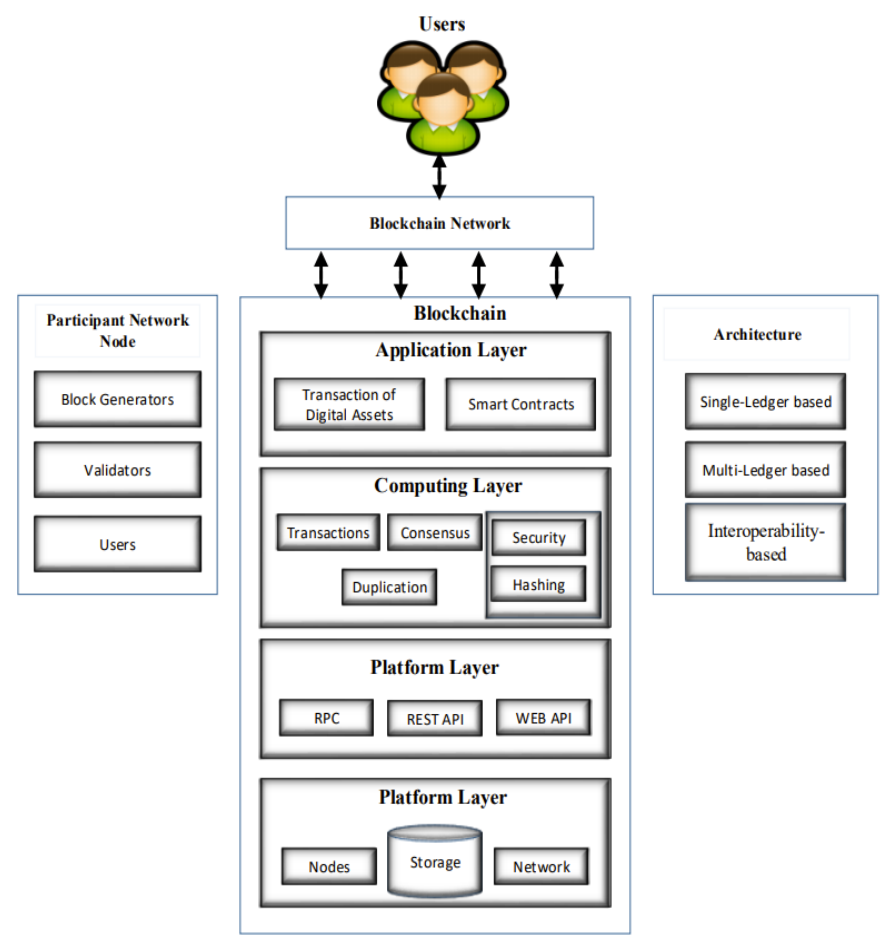
Figure 1. Architecture of blockchain.